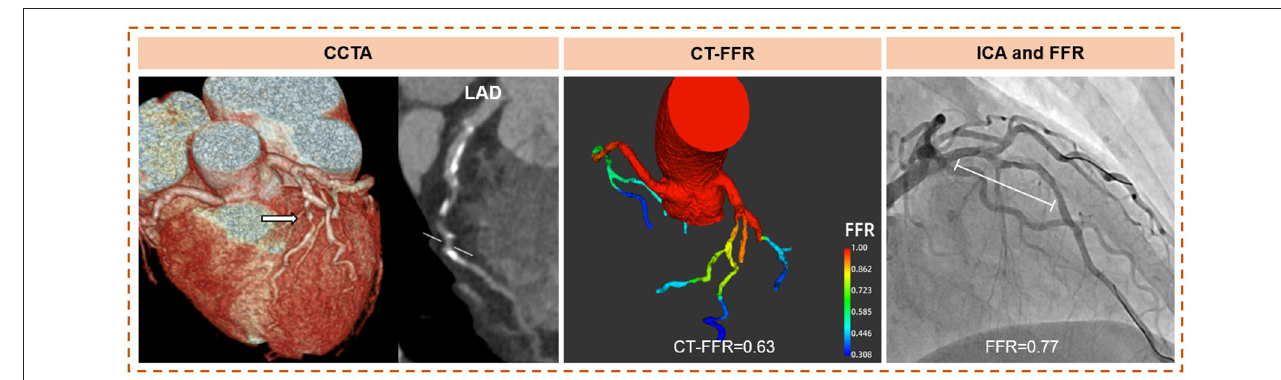
FIGURE 5 | Case of CT-FFR estimating coronary lesions with severe calcification. Example of a 66-year-old female with stable chest pain. The CAC scores of LAD, LCX, and RCA were 599.6, 216.4, and 716.2. CCTA showed multiple calcified and mixed plaques causing more than 70% stenosis in the proximal and mid LAD. CT-FFR demonstrated functional ischemia (CT-FFR = 0.63) caused by LAD stenosis, and confirmed by FFR (FFR = 0.77). The deviation of CT-FFR was 0.14 in the situation of severe coronary calcification. With the widely-accepted threshold of ischemia ( ≤ 0.8), CT-FFR made a correct dichotomous diagnosis. LAD, left anterior descending coronary artery; LCX, left circumflex artery; RCA, right coronary artery; CT-FFR, computed tomography derived fractional flow reserve; FFR, fractional flow reserve; CAC, coronary artery calcium; CTA, computed tomography